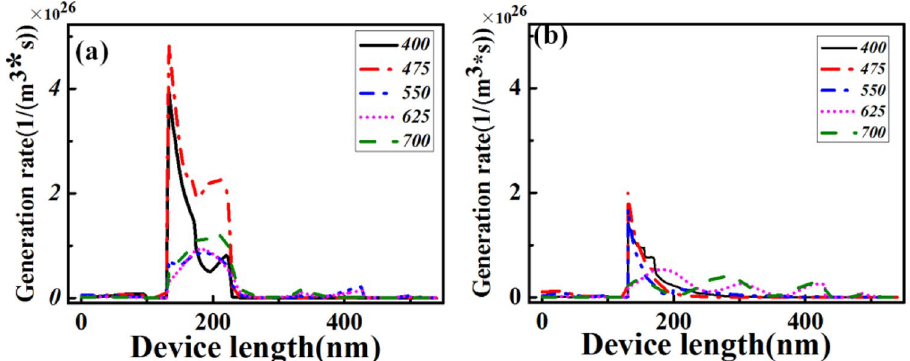
Figure 8. Device position (along the z -direction)-dependent generation rate profiles of charge carrier for the optimized case V ( a ) and reference ( b ) at several typical incident wavelengths.